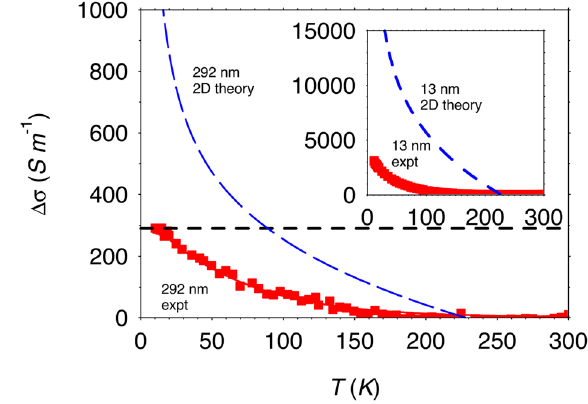
Fig. 1 Temperature dependence of magnetoconductivity. Closed red squares: experimental Δ σ data in units of S m − 1 for 292- and 13-nm layers. Dashed blue curved lines: predictions of 2D theory, normalized to 292nm in main plot and 13nm in inset. Dashed black straight line: Δ σ = 290.8S m − 1 , the Kawabata 3D prediction at very low